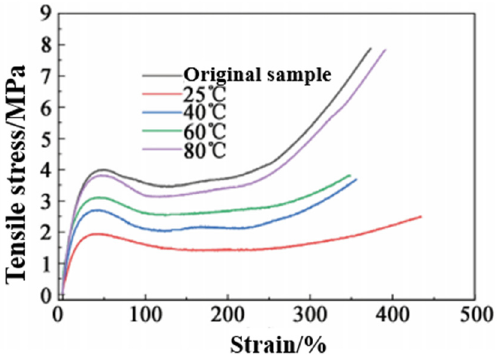
Figure 11. Tensile stress-strain curve of PUSS-6 after self-repair at different temperatures. Table 3. Tensile strength and self-repair efficiency of Puss 6 after self-repair at different temperatures. Self-Healing